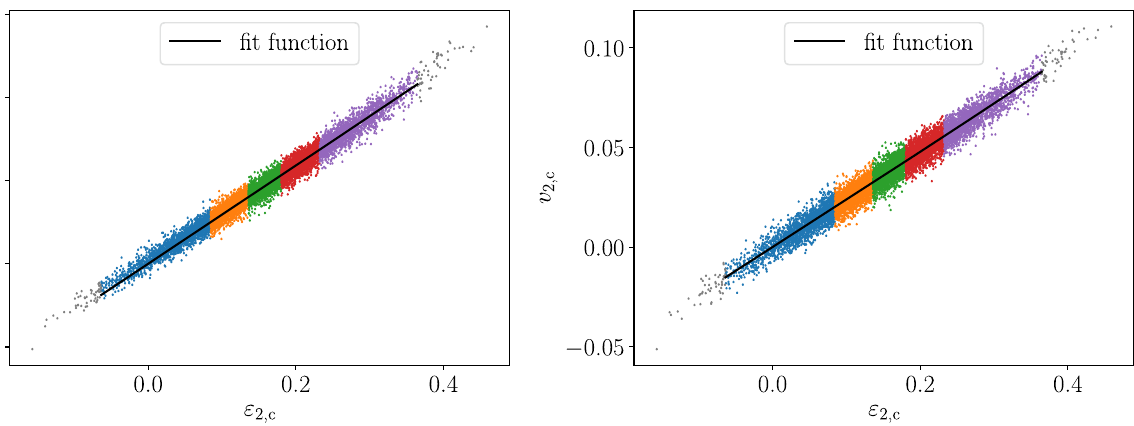
Fig. 4 Scatter plot of the final v 2 , c vs. ε 2 , c for events at b = 6 fm with (cid:3) Kn (cid:4) − 1 = 0 . 34 (left) and (cid:3) Kn (cid:4) − 1 = 13 . 74 (right). The full curves are fits with Eq. (5). The grey points signal the events that are removed from